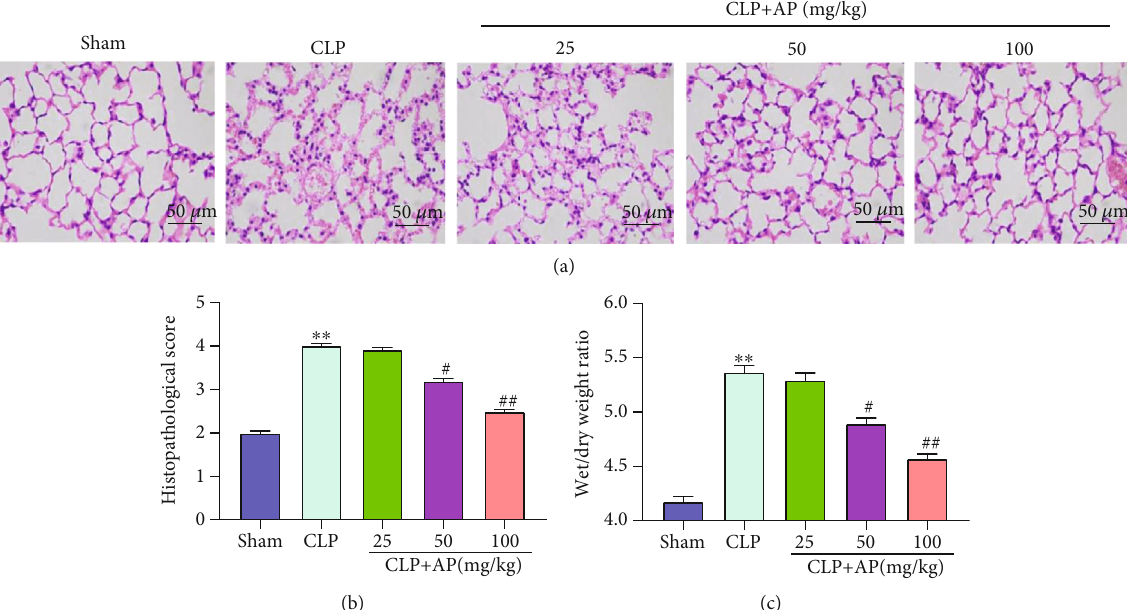
Figure 1: AP protected mice against sepsis-induced ALI and lung edema. (a) Pathological changes in the lung tissues observed by HE staining (100x). (b) Histological score of lung tissue. (c) The lung wet weight/dry weight ratio was assessed among experimental groups. ∗∗ P < 0 : 01 , vs. Sham group; # P < 0 : 05 , ## P < 0 : 01 , vs. CLP